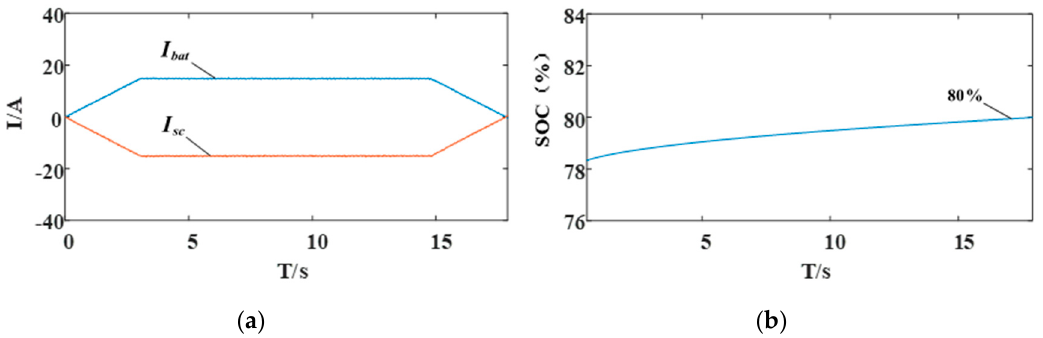
Figure 15. Super Capacitor SOC Automatic Recovery Experiment. ( a ) ESD current; ( b ) Super capacitor SOC.